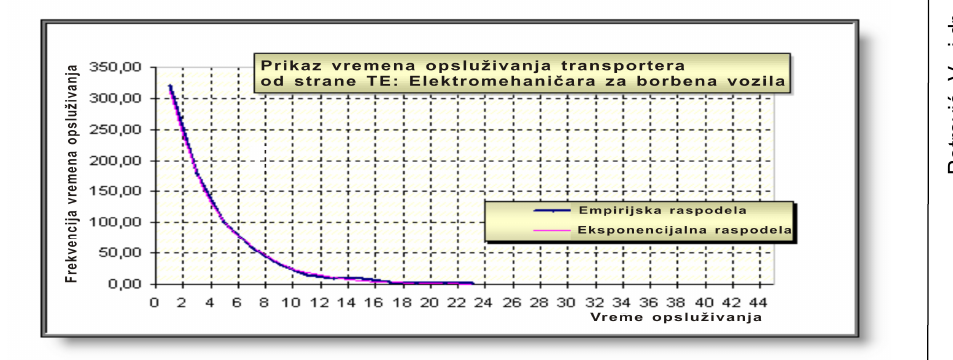
Figure 6 – M-80 served by electro-mechanics for